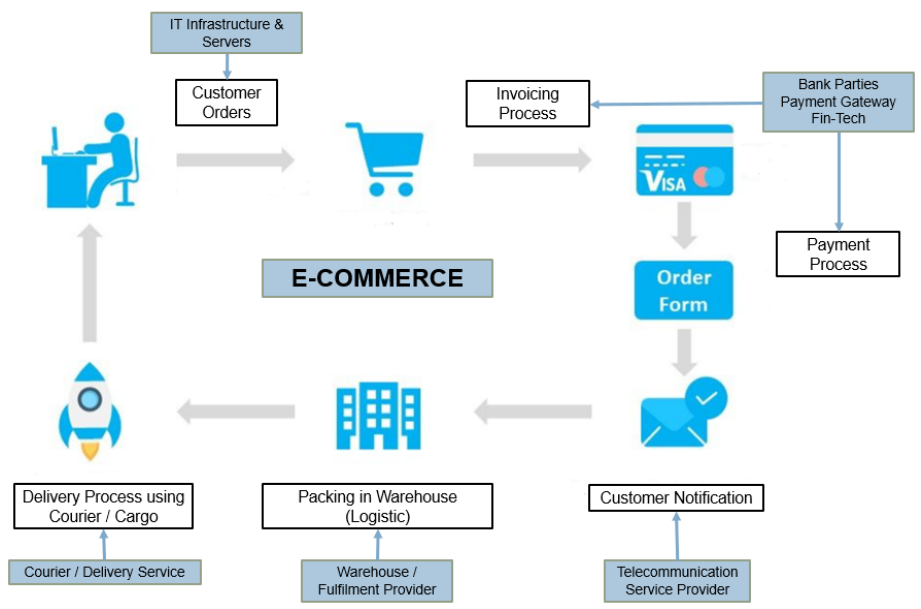
Figure 1. E-commerce collaboration position with partners.